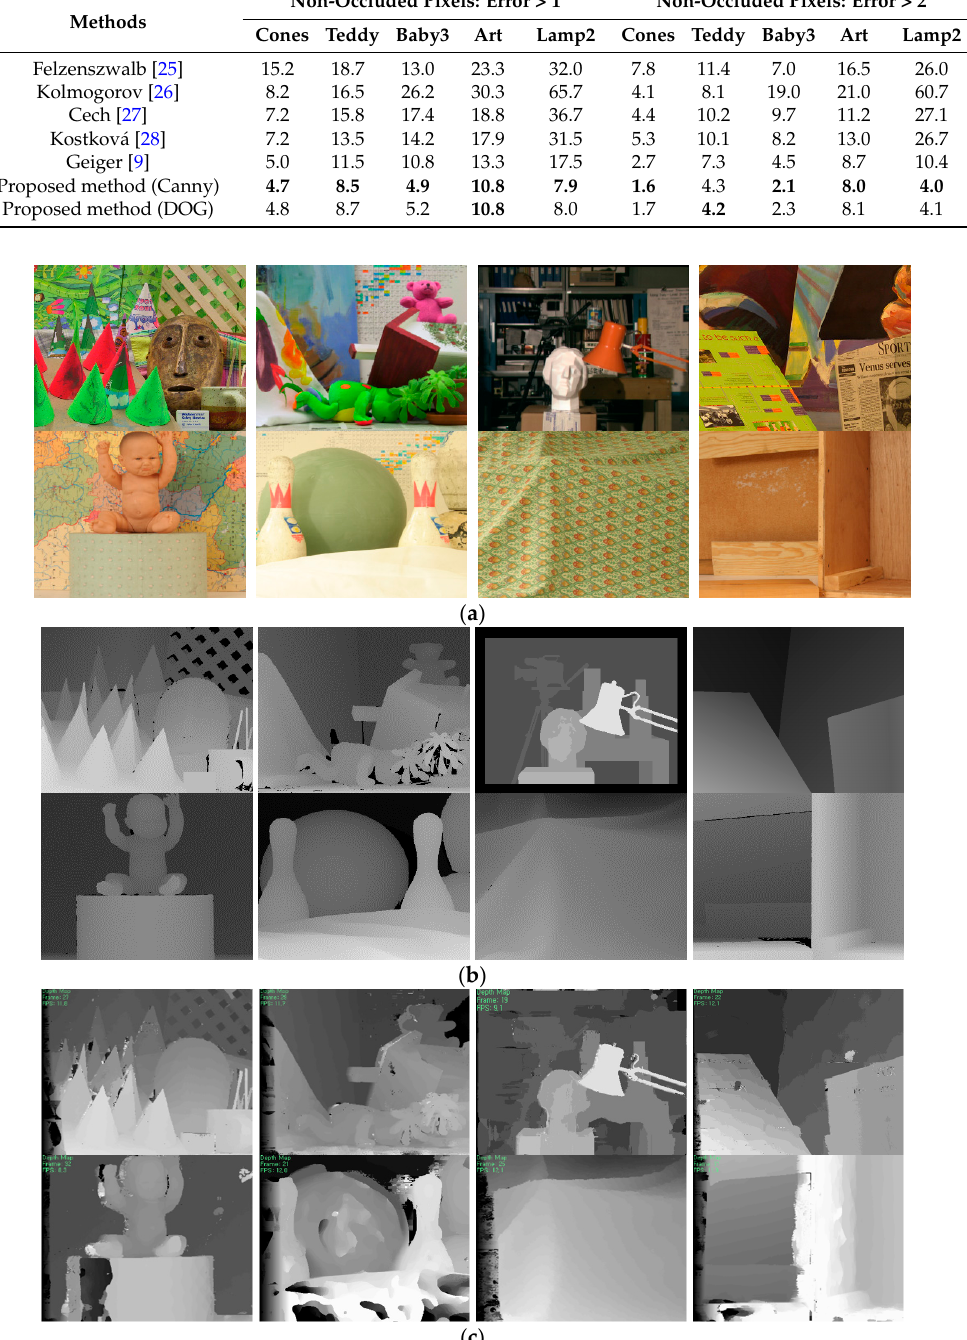
Table 1. Quantitative evaluation results (error rate: %) for Middlebury database set.